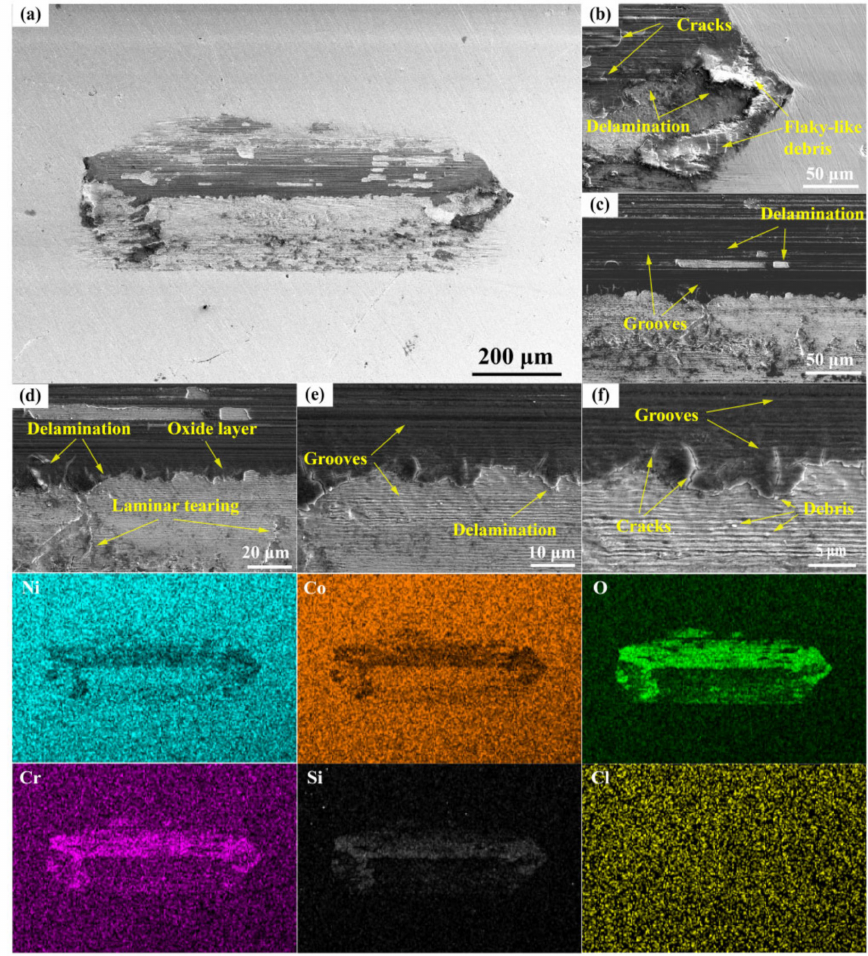
Figure 7. SEM and EDS micrographs of overall morphology ( a ) and some details ( b - f ) of the wear track for CoCrNi tested in 3.5 wt. % NaCl solution at − 0.8 V applied